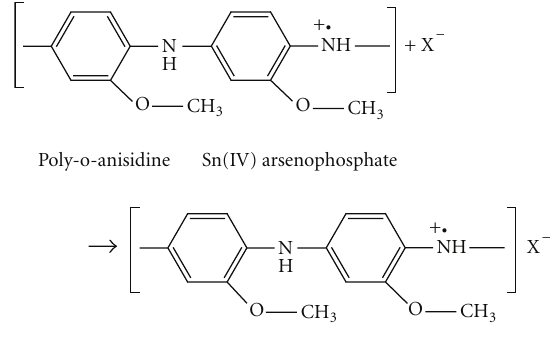
Poly-o-anisidine Sn(IV) arsenophosphate composite